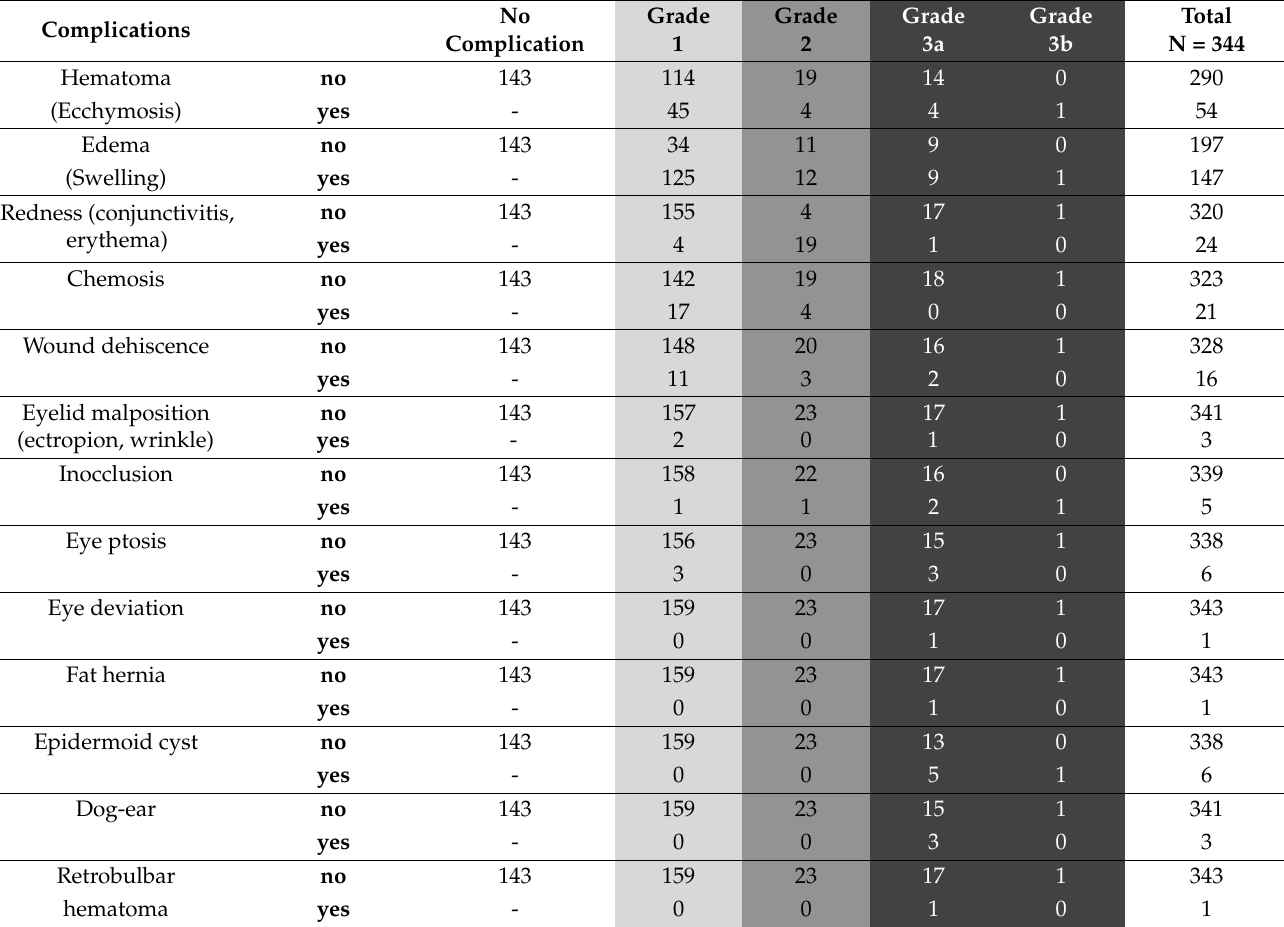
Table 2. Outcome complications according to CDC